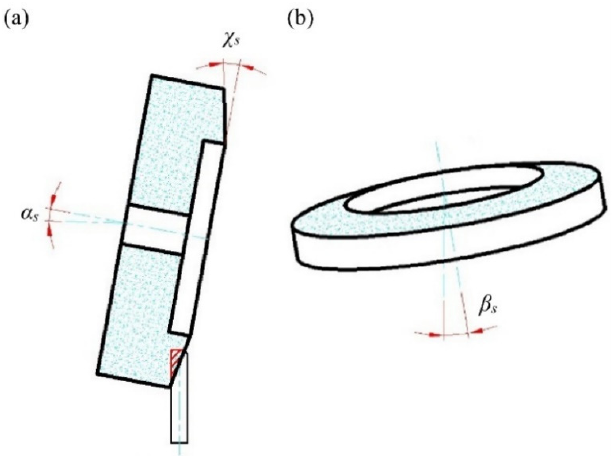
Figure 3. Diagram of the angular positioning of the grinding wheel in three planes with respect to the planar blade: ( a ) side view; ( b ) front view.